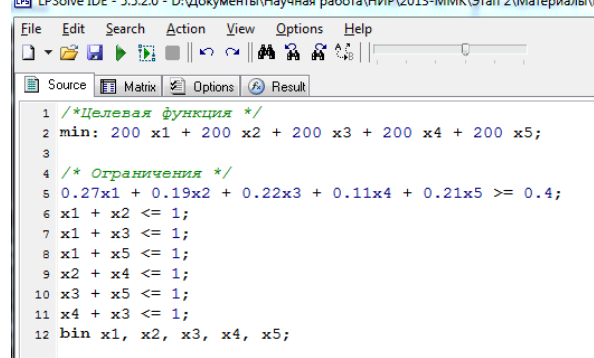
Figure 4: An example of recording the input data of mathematical model in program LPSolve